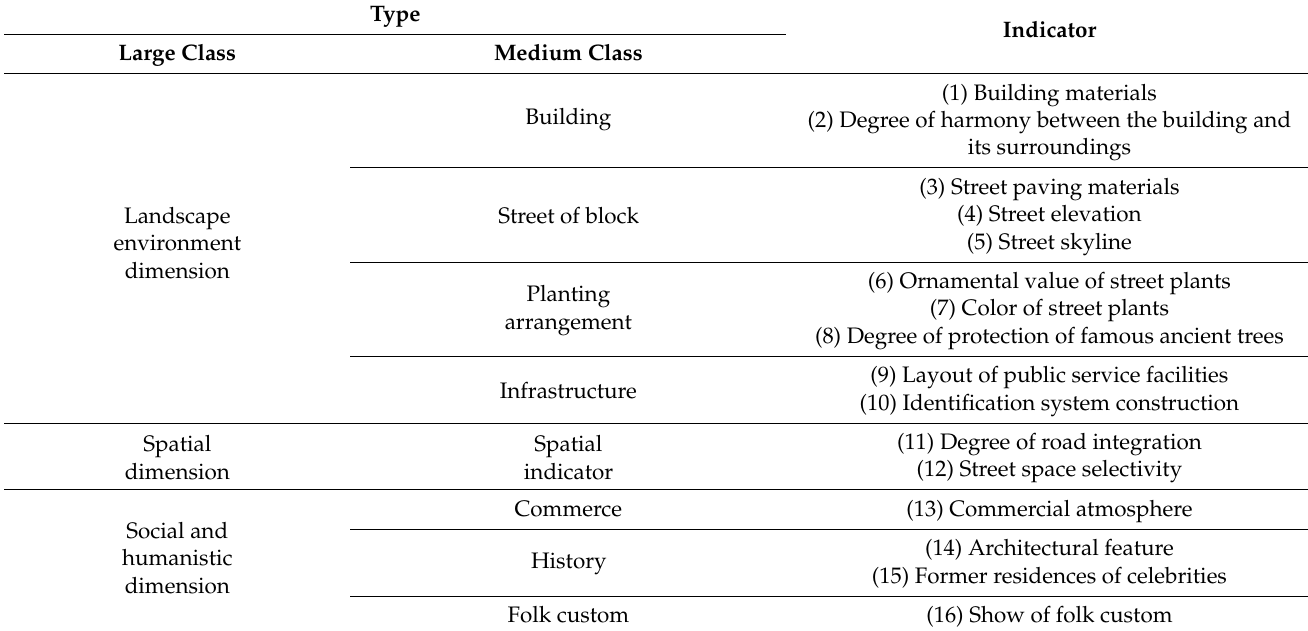
Table 3. Landscape preference indicator system.